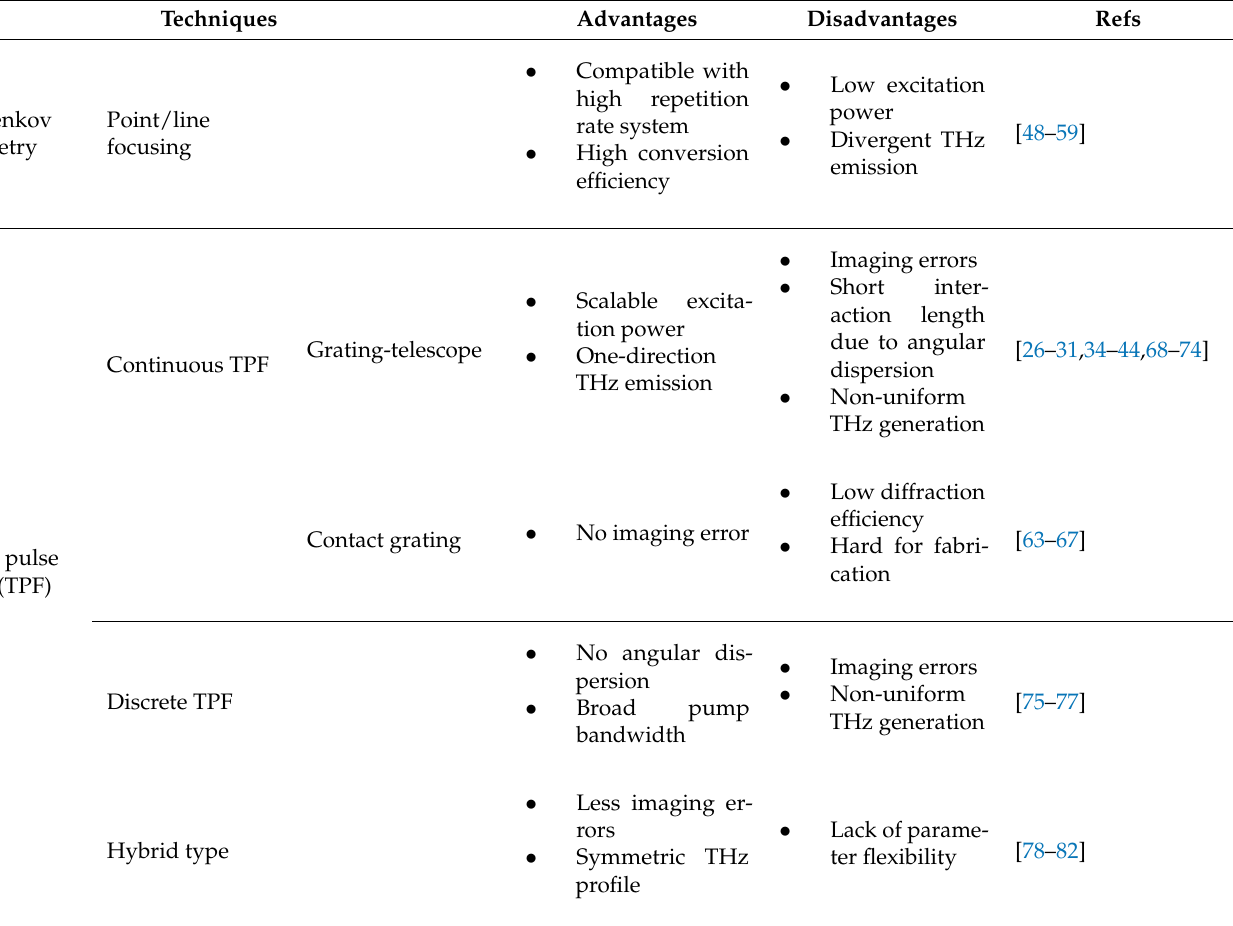
Table 1. Comparison of techniques to generate single- to few-cycle THz pulses from LN. Techniques